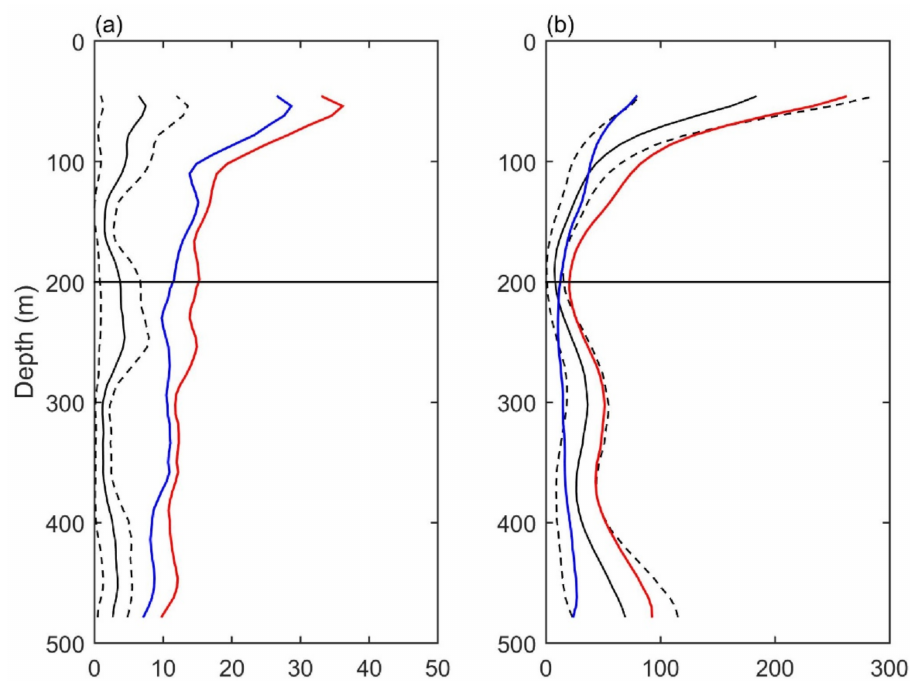
Figure 7. Mean HKEs (unit: J m − 1 ) of diurnal ( a ) and semidiurnal ( b ) currents (red lines) and their coherent component (black lines, where dashed lines represent one standard deviation) and incoherent (blue lines)